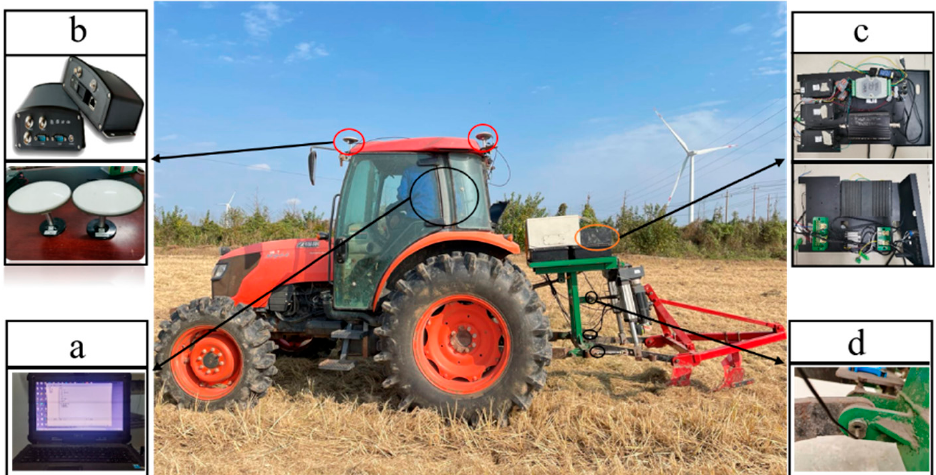
Figure 1. Data acquisition platform. ( a ) Host computer; ( b ) P3-DT BeiDou navigation system; ( c ) controller; ( d ) shaft pin sensor. The position indicated by the arrow in ( d ) is the three-point hitch upper link at the back end.